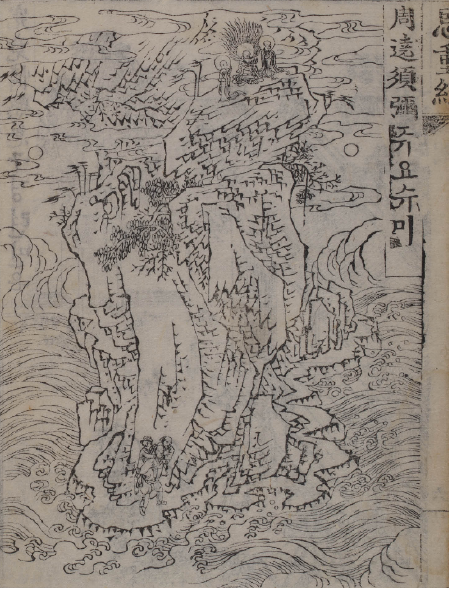
Figure 17. “Going around Mount Sumeru” from the vernacular Korean edition of Sūtra on Deep Indebtedness to One ʼ s Father and Mother. Chosŏn, 1796. Woodblock printed on paper. 22.0 × 16.0 cm. Courtesy of Dongguk University Library.